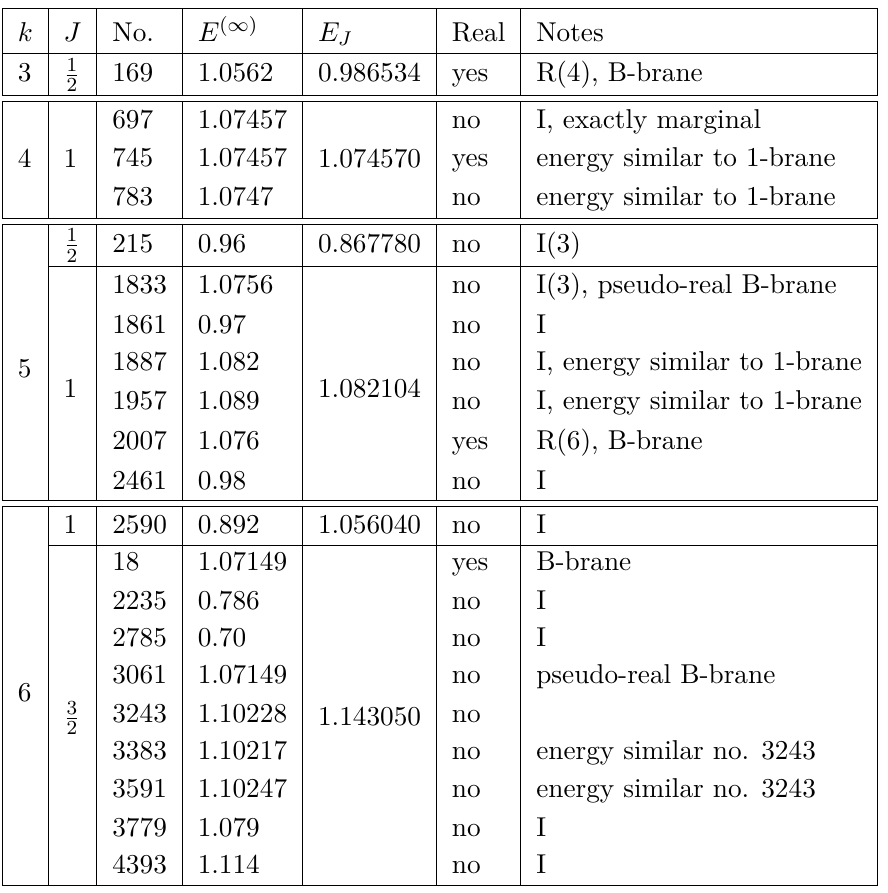
Table 27 . List of exotic solutions in the SU(2) k WZW model with k ≤ 8 , part 1. The structure